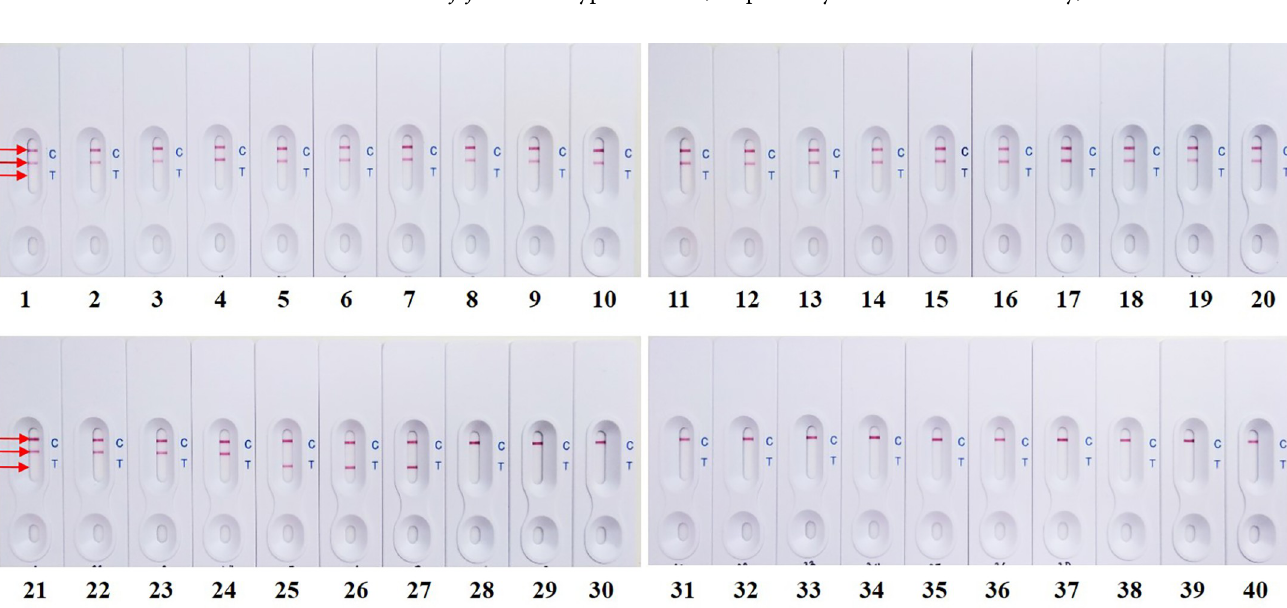
Fig 3. The specificity of d-LAMP-LFB assay for detection of different strains of 20 ng each of DNA templates. 1: S . Agona DMST 10638; 2: S . Abony DMST 21863; 3: S . Anatum DMST 16870; 4: S . Arizonae DMST 22439; 5: S . Bangkok DMST 7121; 6: S . Bergen DMST 10895; 7: S . Cerro DMST 17381; 8: S . Derby DMST 8535; 9: S . Enteritidis DMST 15676; 10: S . Gallinarum DMST 15968; 11: S . Hvittingfoss DMST 15681; 12: S . Mbandaka DMST 17377; 13: S . Newport DMST 15675; 14: S . Panama DMST 10640; 15: S . Paratyphi B DMST 28118; 16: S . Poona DMST 15679; 17: S . Schwarzengrund DMST 17364; 18: S . Senftenberg DMST 17013; 19: S . Stanley DMST 16874; 20: S . Typhi DMST 5784; 21: S . Typhimurium ATCC 23566; 22: S . Typhimurium DMST 562; 23: S . Wandsworth DMST 19204; 24: S . Waycross DMST 19205; 25: C . jejuni DMST 15190; 26: C . coli DMST 18034; 27: C . lari DMST 17953; 28: B . cereus ATCC 14579; 29: E . aerogenes DMST 2720; 30: E . coli DMST 703; 31: E . coli DMST 4212; 32: L . monocytogenes DMST 17303; 33: S . boydii DMST 30245; 34: S . aureus ATCC 25923; 35: S . epidermidis DMST 15505; 36: S . haemolyticus DMST 15511; 37: V . cholera DMST 2873; 38: V . vulnificus DMST 21245; 39: Y . enterocolitica DMST 8012; 40: blank